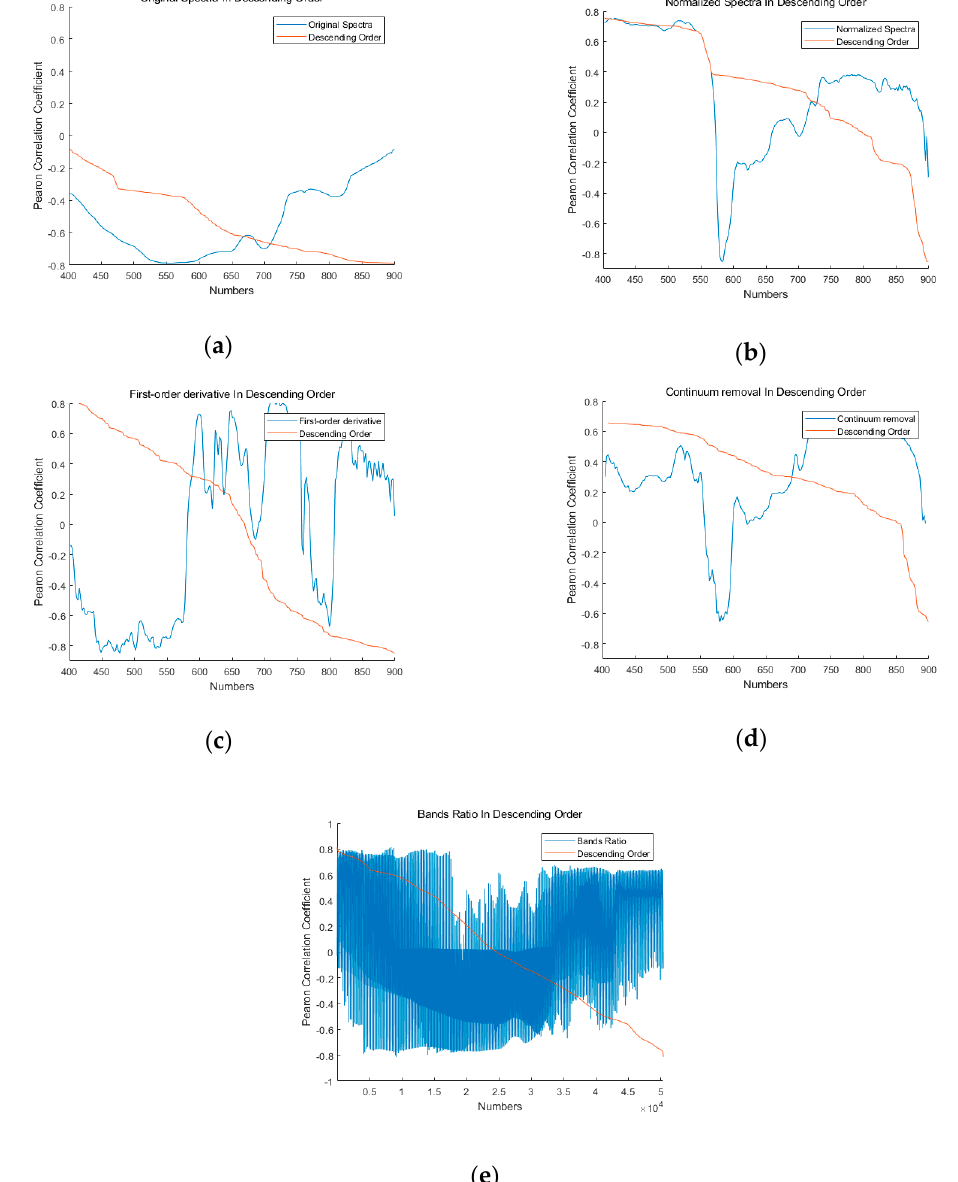
Figure 9. Pearson’s correlation coefficients with suspended solids concentration: ( a ) Original spectra. ( b ) Max-Min normalization result. ( c ) First-order derivative result. ( d ) Continuum removal result. ( e ) Band ratio result.